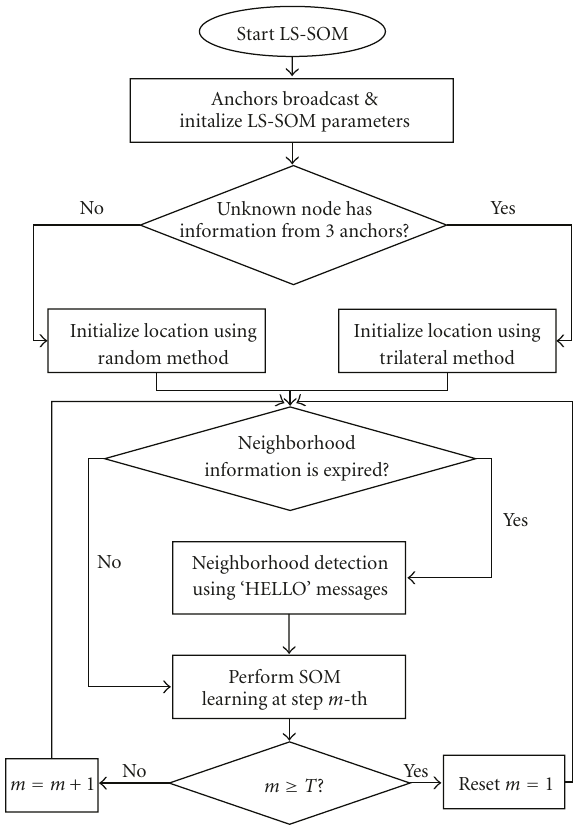
Figure 4: Repeated learning in mobile environment. nodes’ locations, and edges are the connectivity information (direct connection between neighboring nodes). The target wireless ad-hoc network is formed by G anchors with known locations Ω i ( i = 1,2, ... , G ) and N nodes with unknown locations. The unknown nodes have actual locations